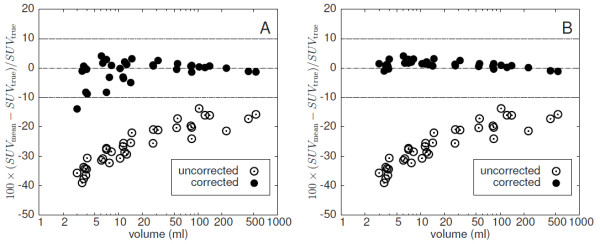
Deviation of GBPVC-corrected (A) and LBPVC-corrected (B) SUVmeanfrom the true SUVmeanusing the true object boundaries (at a noise level of FWHM = 5%). The Uncorrected SUVmean is shown for comparison. Note the logarithmic scale of the abscissa.